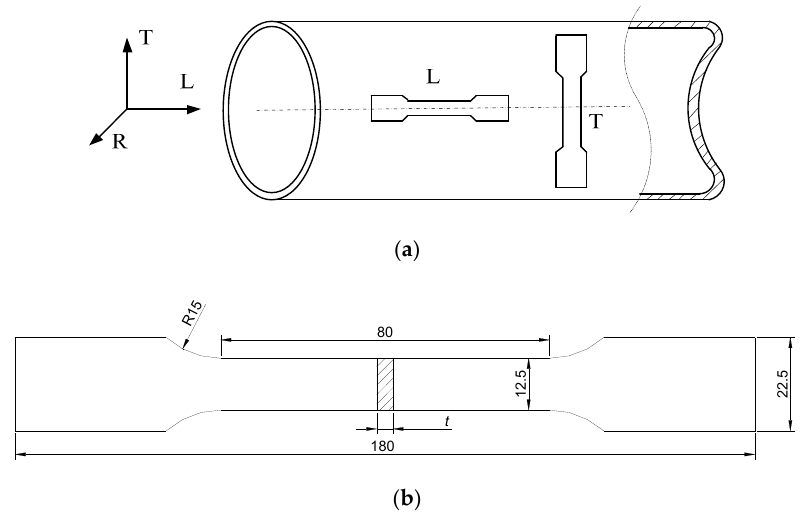
Figure 2. Specimens for tensile test, ( a ) Sampling direction ( b ) Specimen sizes.